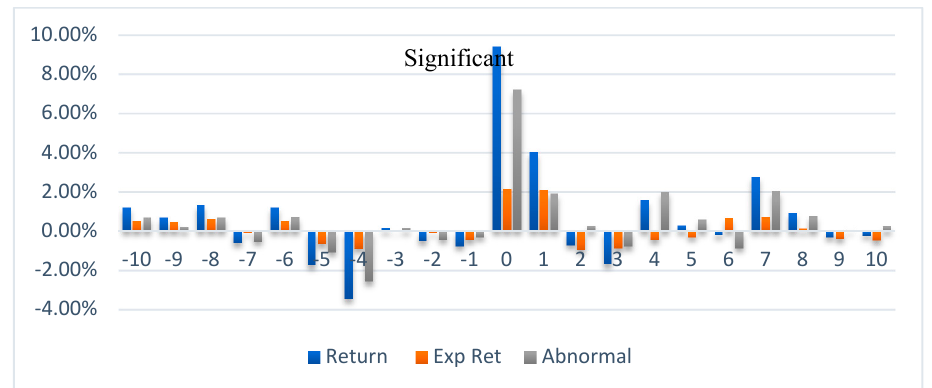
Figure 5. Private Equity ETF.